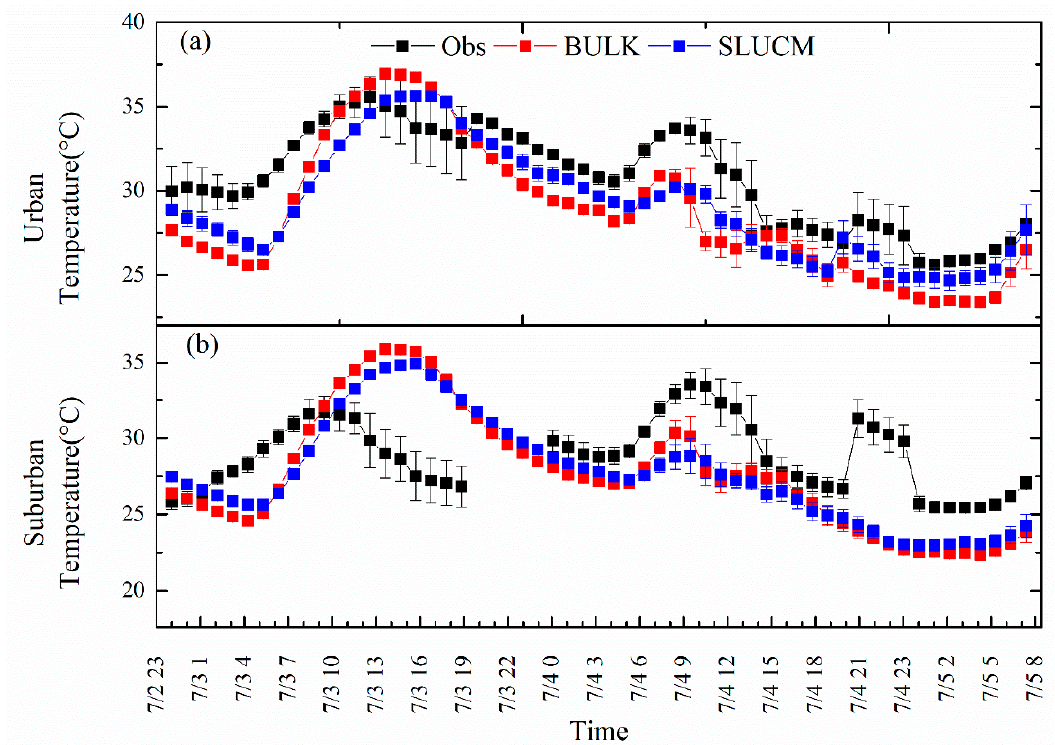
Figure 9. Time series of temperatures as the cold front passed over Shanghai at 11 sites divided into two areas: ( a ) urban sites containing s1, s2, s3, and Minhang; ( b ) suburban sites containing s4, Nanhui, Qingou, Chongming, Jinshan, and Fengxian.